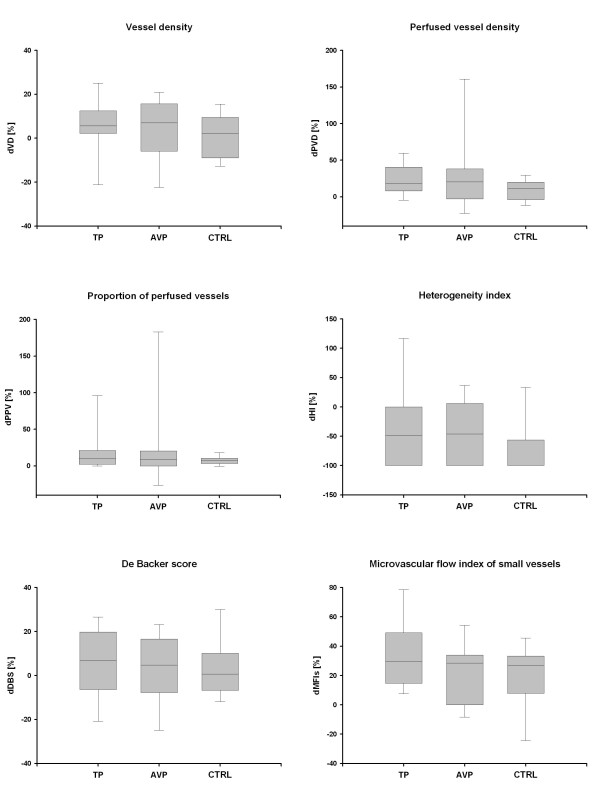
Relative changes in microcirculatory variables. Data represent relative changes from baseline (BL) at 6 hours. AVP, arginine vasopressin; dDBS, relative changes in De Backer Score; dHI, relative changes in heterogeneity index; dMFI, relative changes in microvascular flow index of small vessels (Ø < 20 μm); dPPV, relative changes in proportion of perfused vessels; dPVD, relative changes in perfused vessel density; dVD, relative changes in vessel density; CTRL, control; TP, terlipressin. Solid lines, median; dashed lines, mean; boxes, 25th and 75th percentiles; whisker caps, 10th and 90th percentiles.